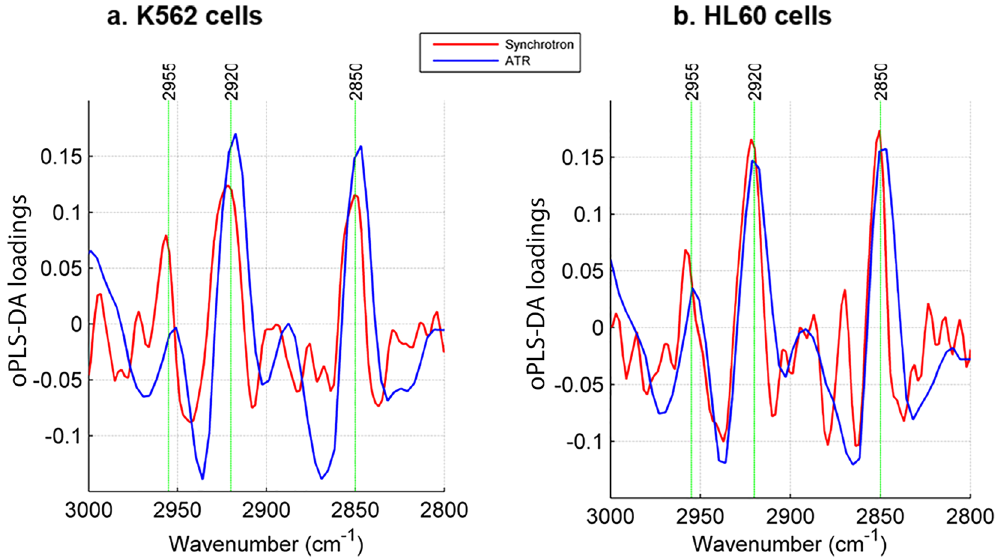
Figure 4. oPLS-DA loadings vectors overlaid for S-FTIR (red) and ATR-FTIR (blue) loadings in the high wavenumber lipid region, for K562 ( a ) and HL60 ( b )